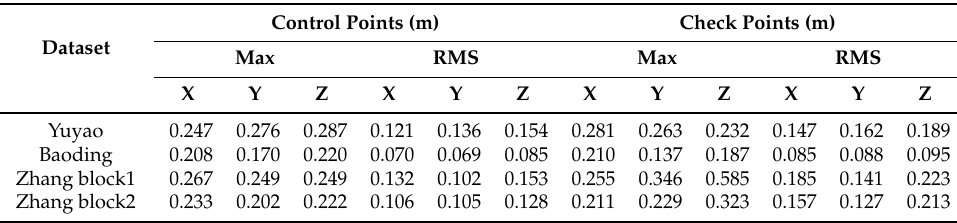
Table 6. Precision of AT in the experimental datasets.